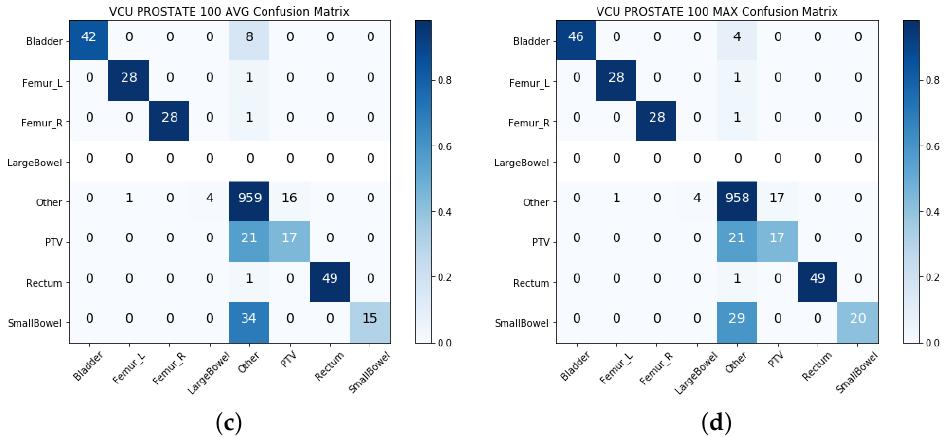
Figure 7. Late integration: confusion matrix for VA-ROQS and VCU prostate datasets: ( a ) VA-ROQS prostate AVG integration, ( b ) VA-ROQS prostate MAX integration, ( c ) VCU prostate AVG integration, and ( d ) VCU prostate MAX integration. A darker color demonstrates more accurate prediction, and the diagonal shows the labels predicted